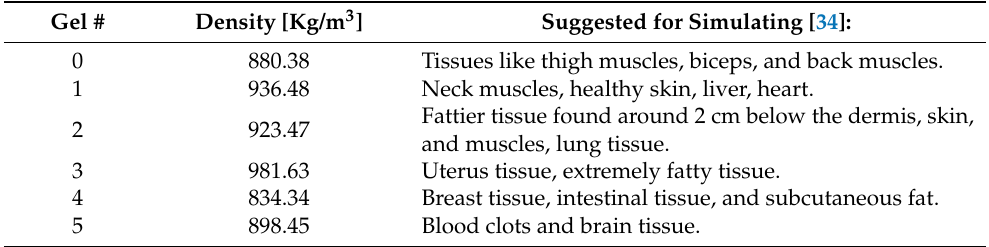
Table 1. Gel identification, densities, and suggested applications. Note: # corresponds to No. Gel # Density [Kg/m 3 ] Suggested for Simulating [34]: 0 880.38 Tissues like thigh muscles, biceps, and back muscles. 936.48 Neck muscles, healthy skin, liver, heart. Fattier tissue found around 2 cm below the dermis, skin, 923.47 and muscles, lung tissue. 981.63 Uterus tissue, extremely fatty tissue. 834.34 Breast tissue, intestinal tissue, and subcutaneous fat. 898.45 Blood clots and brain